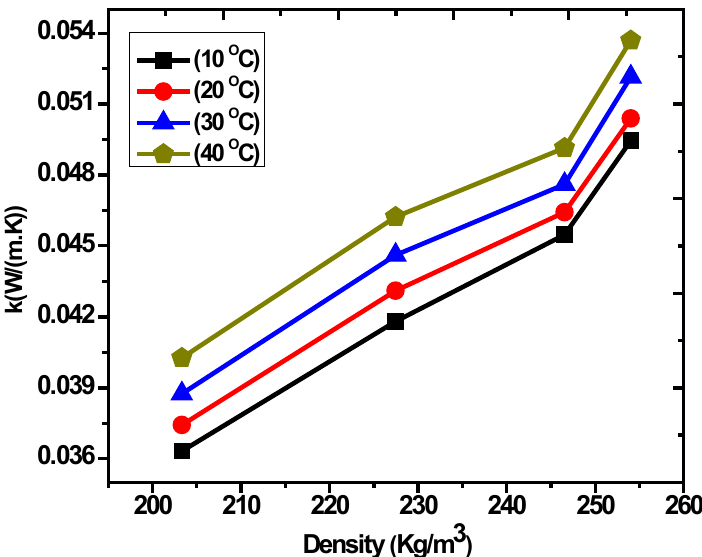
Figure 7. Thermal conductivity profiles of the insulation composite at fixed temperatures.